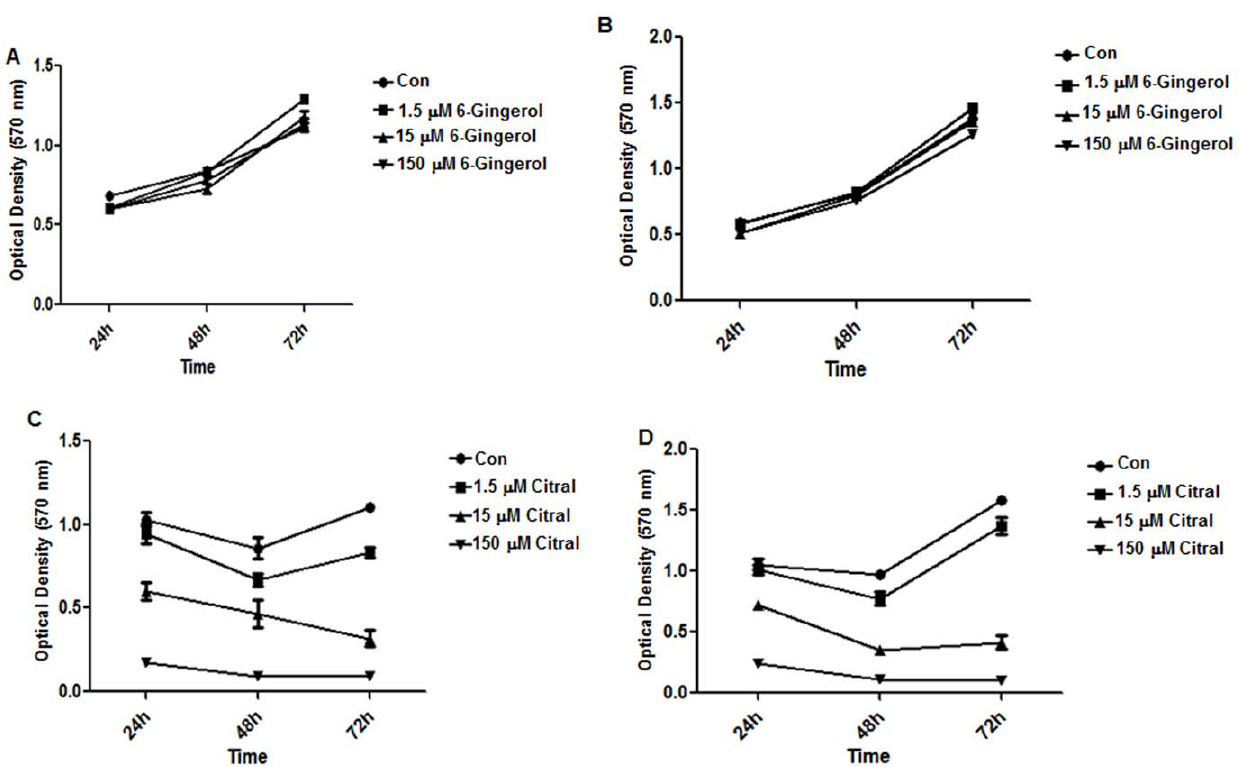
Figure 4. Citral inhibits proliferation of endometrial cancer cells. MTT assays were conducted to determine the effect of 6-gingerol (A and B) and citral (C and D) on the proliferation of Ishikawa and ECC-1 cells. Each data point is a mean of 16 individual readings. Based on this data the IC 50 of citral was calculated to be 15–25 m M.